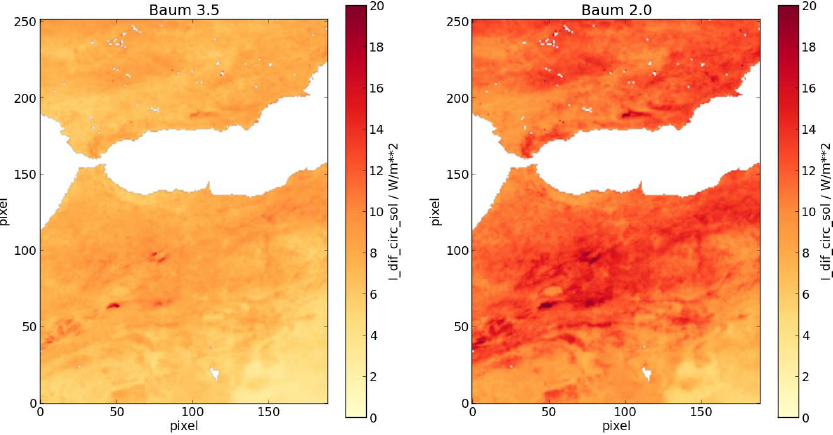
Fig. 9. Circumsolar irradiance for a limiting angle of 2.5 ◦ averaged over all time steps in the test dataset with I tot ,α =2 . 5 ◦ > 200Wm − 2 .